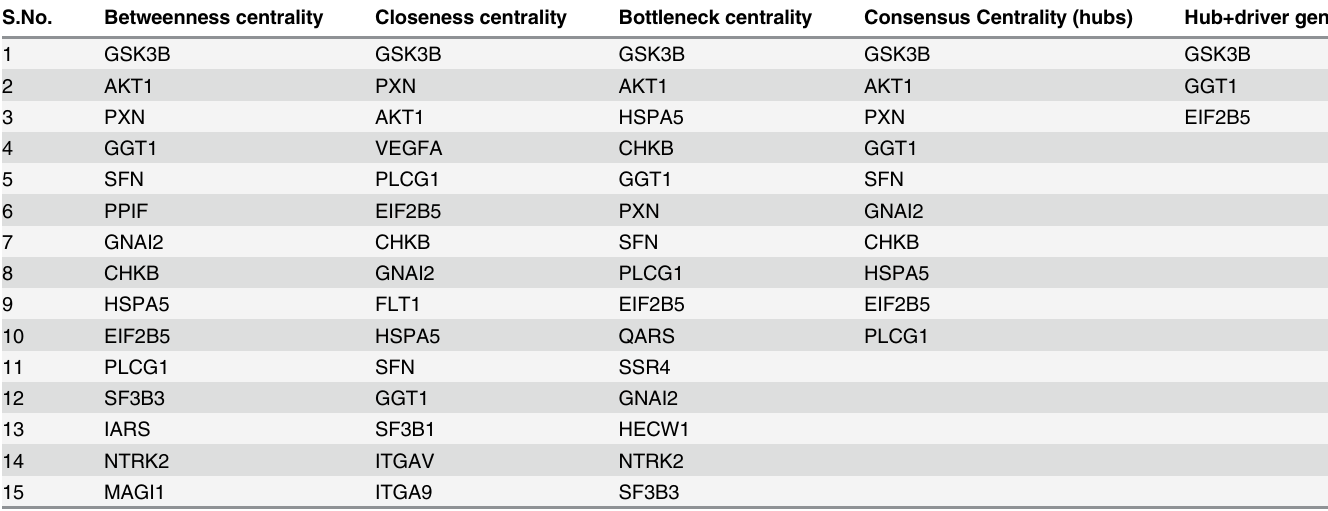
The top 15 genes obtained by applying each centrality metric are given. The genes at the intersection of all the three metrics are designated as ‘ hubs ’ . Genes that are both hub and driver are